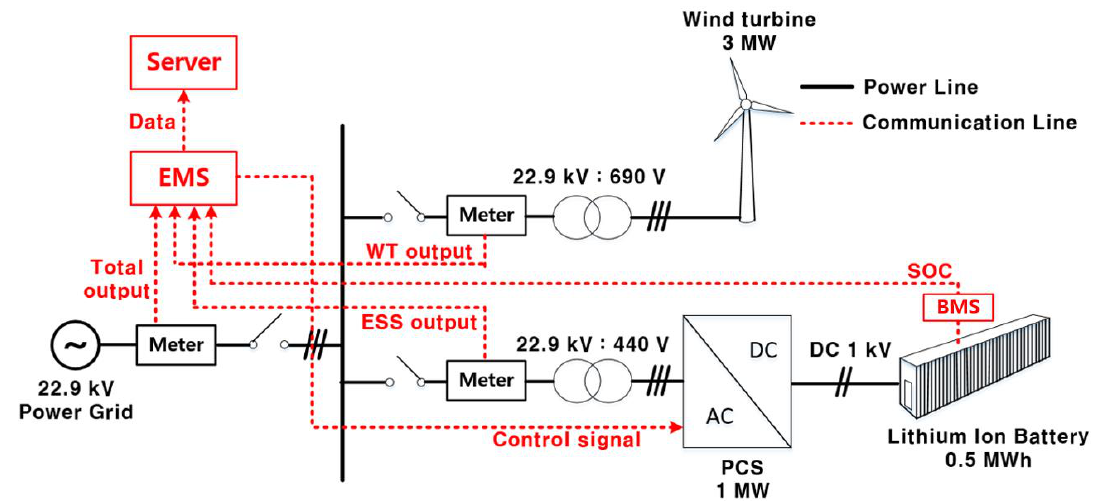
Figure 3. Single line diagram of the pilot project.